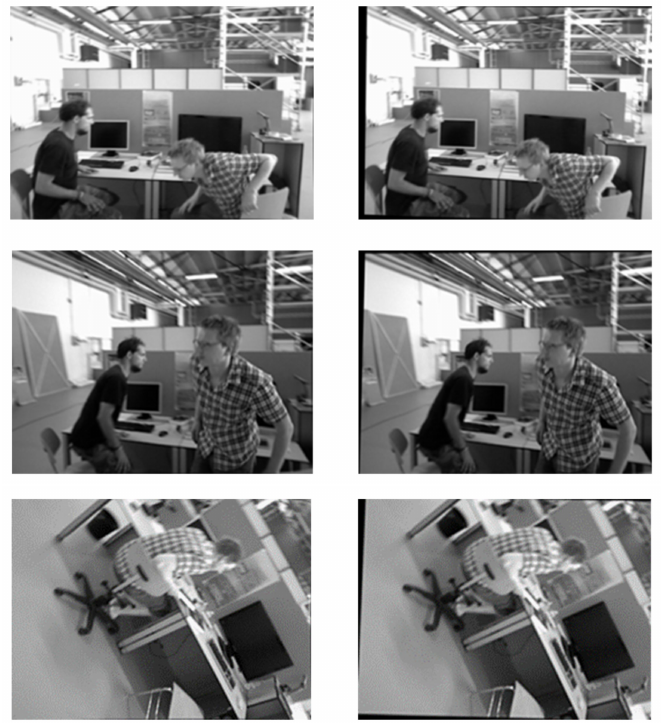
Figure 4. The compensation result of the motion component within the